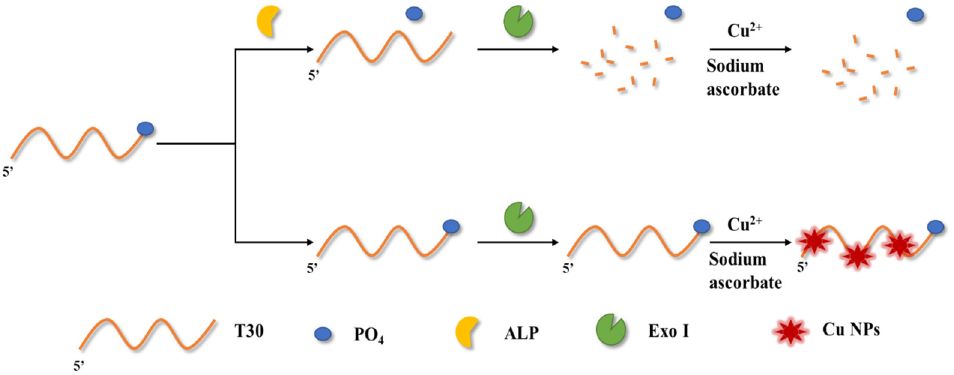
Scheme 1. Schematic illustration of fluorescent ALP activity analysis based on DNA-templated